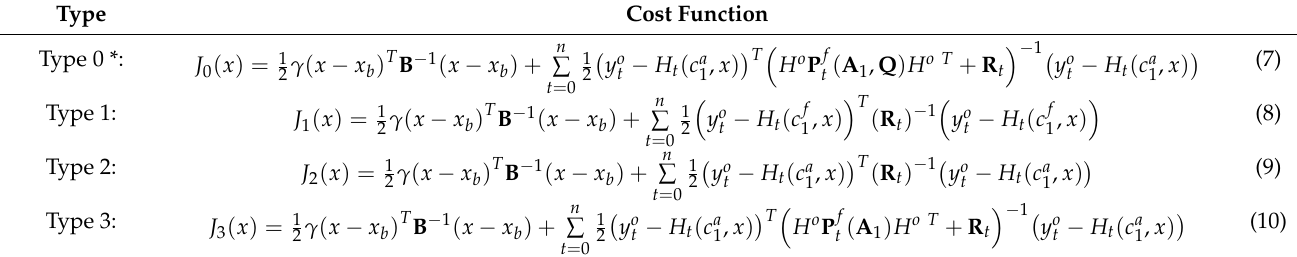
Table 2. Cost functions for different formulations of 4D-Var inversion. P t f is the model-propagated (forecast) of error covariance in the model space, A 1 is the analysis error covariance at the initial time of inversion, and Q is the modelling error covariance that is estimated independently (see Section 3.1). c f and c a represent the initial field of concentrations produced from the hemispheric CMAQ model 1 1 and PvKF assimilation, respectively. * Type 0 is the form of the 4D-Var cost function proposed by this